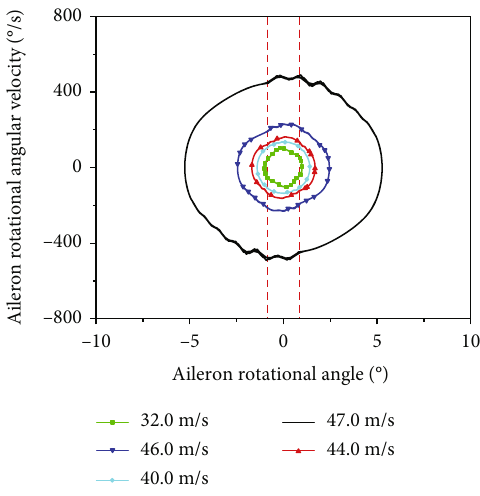
Figure 20: Portraits of aileron rotational DOF at di ff erent